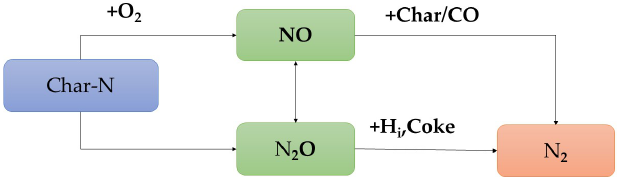
Figure 1. Conversion of char-N during